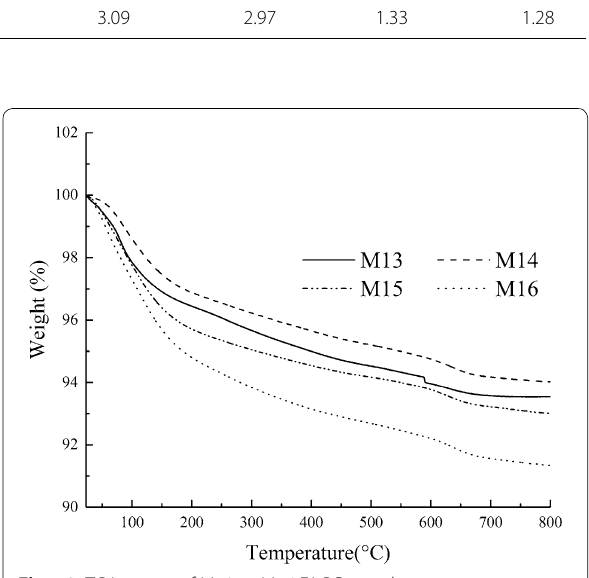
Fig. 10 TGA curves of M13 to M16 FAGC